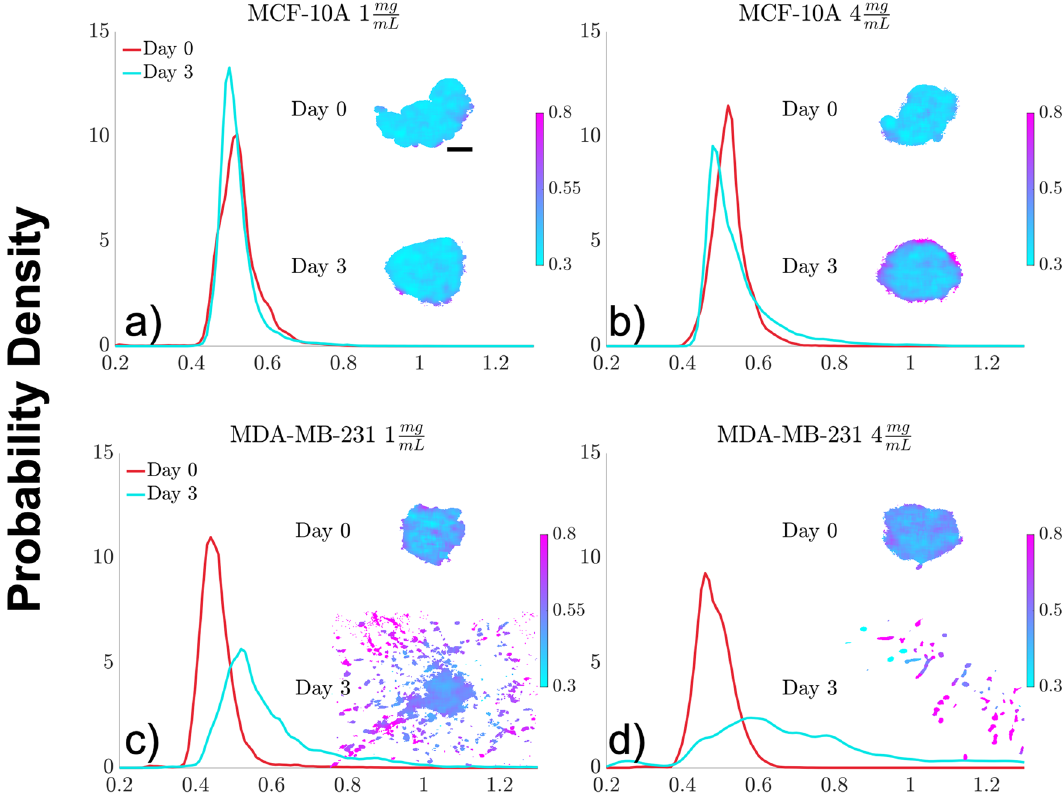
Figure 3. Probability Density Function (PDF) estimates of FLIRR values and representative FLIRR maps. Kernel Density Estimates of PDFs of pooled FLIRR values across the three replicates are shown for MCF-10A at ( a ) 1 mg/ml and ( b ) 4 mg/ml for Day 0 (red) and Day 3 (turquoise) along with a representative example of a FLIRR map with a scale bar representing 100 µm. MDA-MB-231 PDFs are shown at ( c ) 1 mg/ml and ( d ) 4 mg/ ml for Day 0 (blue) and Day 3 (orange) along with representative examples of FLIRR maps. The spheroids are all shown over their entire 825 × 825 µm field of view. MCF-10A spheroids demonstrated a small decrease in FLIRR values towards glycolysis with a larger change at 4 mg/ml. MDA-MB-231 spheroids exhibited a large increase in FLIRR values from Day 0 to Day 3, consistent with a shift towards OXPHOS, accompanied with an increase in